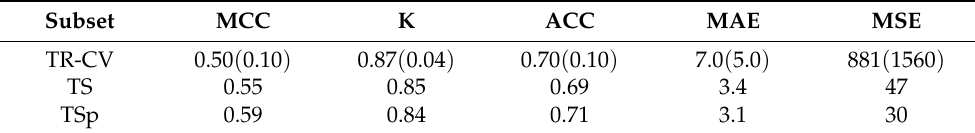
Table 1. Classification results (in terms of mean and standard deviation mean (st.dev) of the perfor- mance metrics for repeated experiments) for different EUNet models: in cross-validation on the training set (TR-CV), in training on the whole TR and inference on the test set, before (TS) and after (TSp) postprocessing (see Section 4.4). MCC: Matthews correlation coefficient; K: Cohen